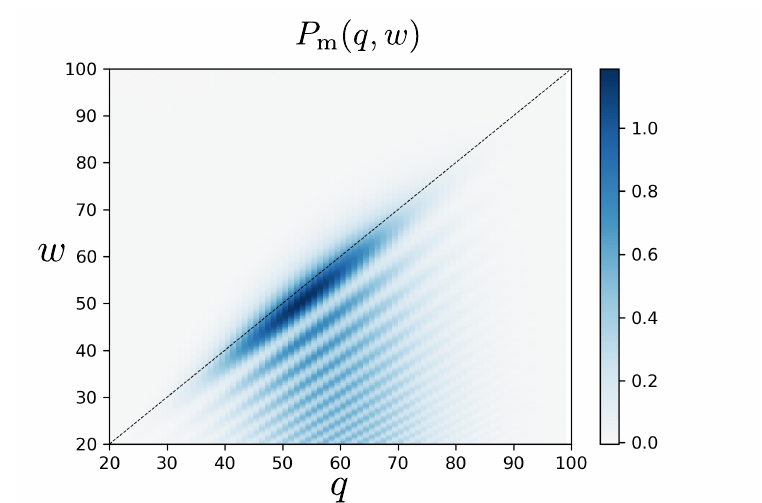
Figure 4: Distribution describing a measurement of heat and work. While heat is assumed to be measured perfectly (e.g., by monitoring the photons that enter and leave the system), the measurement of work is described by Eq. (8). The measure- ment strength is quantified by σ = 0.35. The rest of the parameters are the same as in Fig. 2